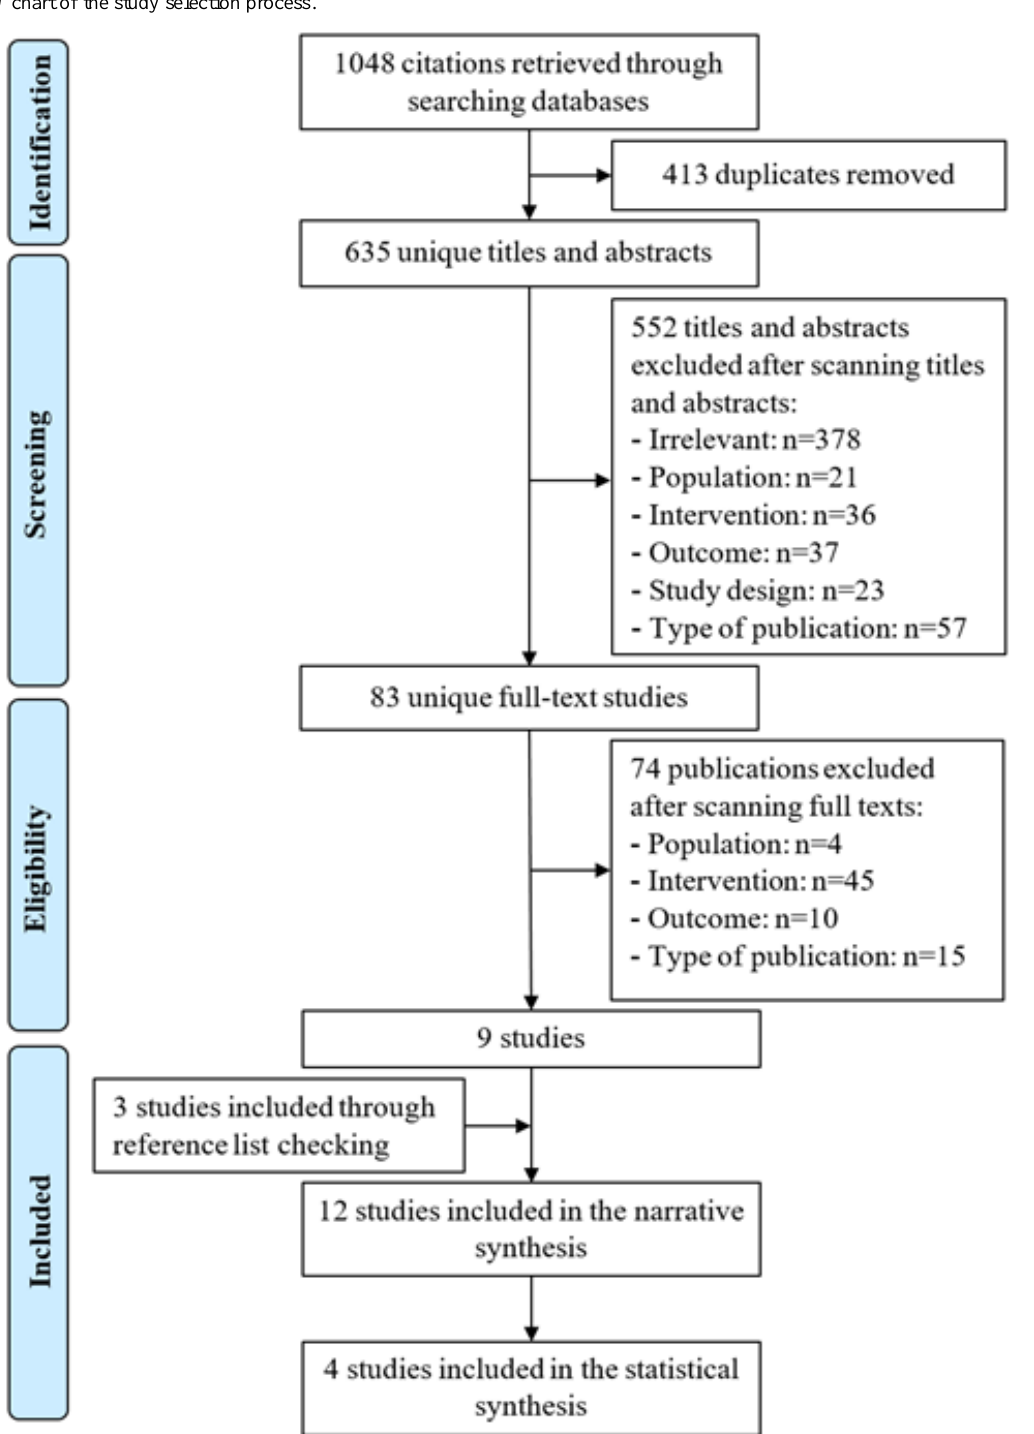
Figure 1. Flow chart of the study selection